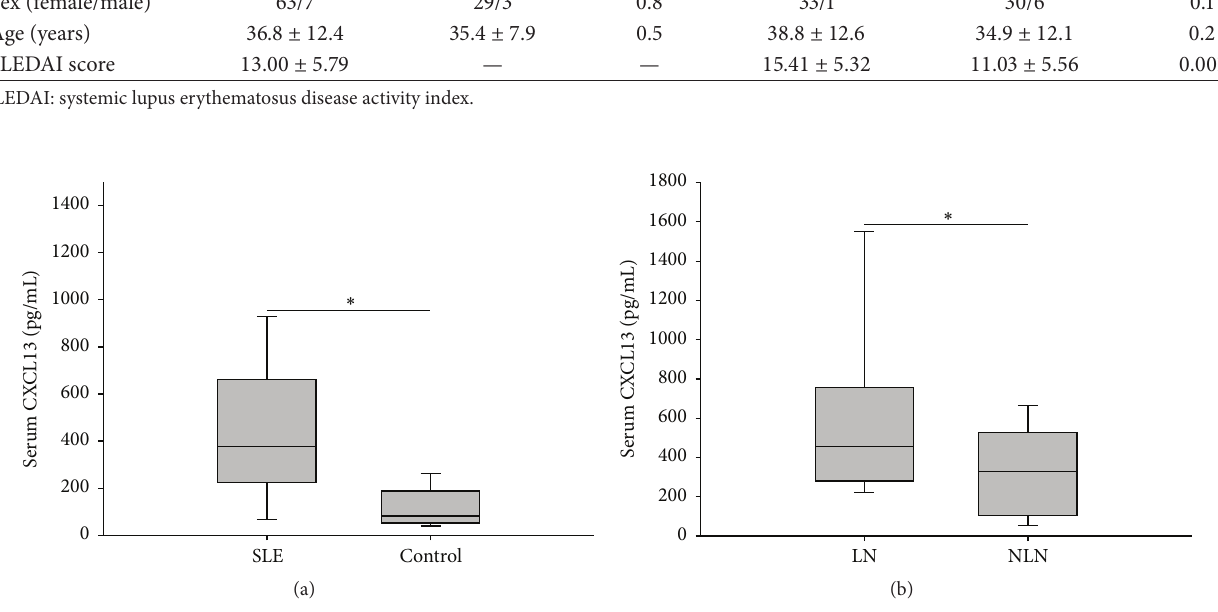
Figure 1: The expression of CXCL13 was increased in SLE especially in LN. (a) Serum CXCL13 of SLE patients and healthy controls. ∗ 𝑃 < 0.001 . (b) Serum CXCL13 of lupus nephritis (LN) and nonlupus nephritis (NLN). ∗ 𝑃 = 0.004 .